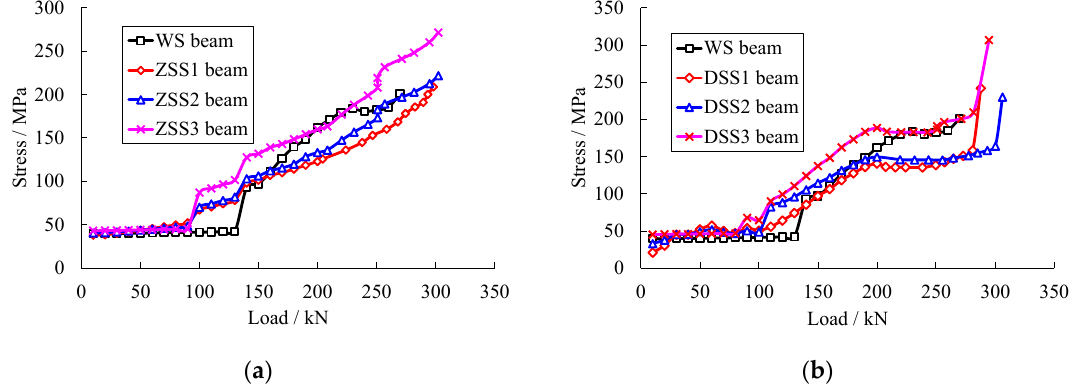
Figure 9. Stress distribution of tensile reinforcement at the main crack in mid-span. ( a ) Pre-cracked test beam at mid-span; ( b ) Pre-cracked test beam at l /4